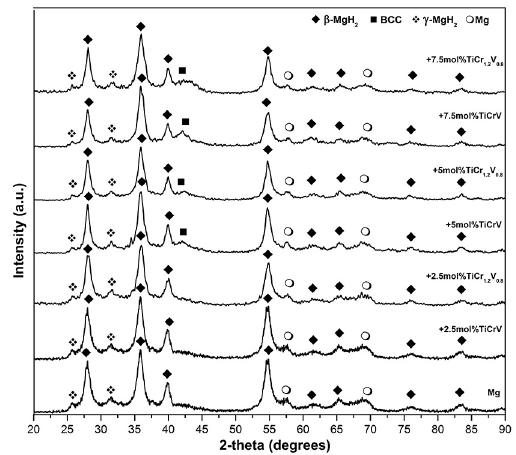
Figure 2. XRD patterns of Mg pure and Mg-based nanocomposites containing 2.5, 5 and 7.5 mol % of TiCrV and TiCr under hydrogen for 24 hours.